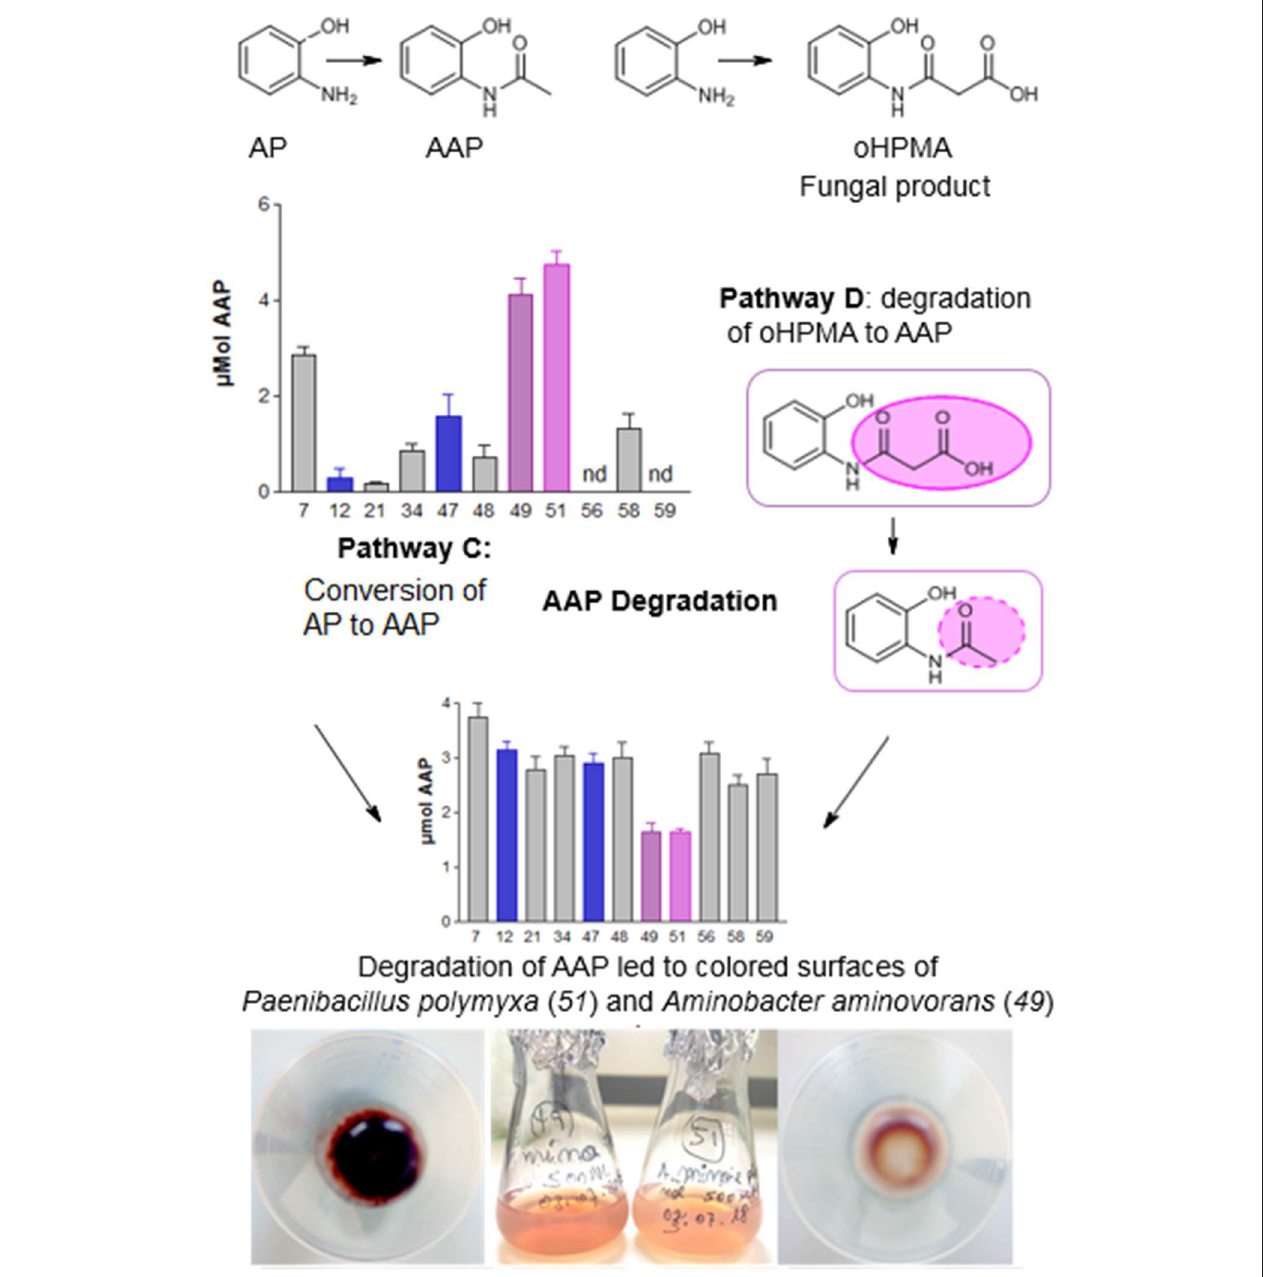
FIGURE 11 | Pathways C and D. The scheme depicts AAP formation from AP and decrease of the compound in the media by Paenibacills polymyxa ( 51 ) and Aminobacter aminovorans ( 49 ). The rose color results from purple compounds on the bacterial surface.